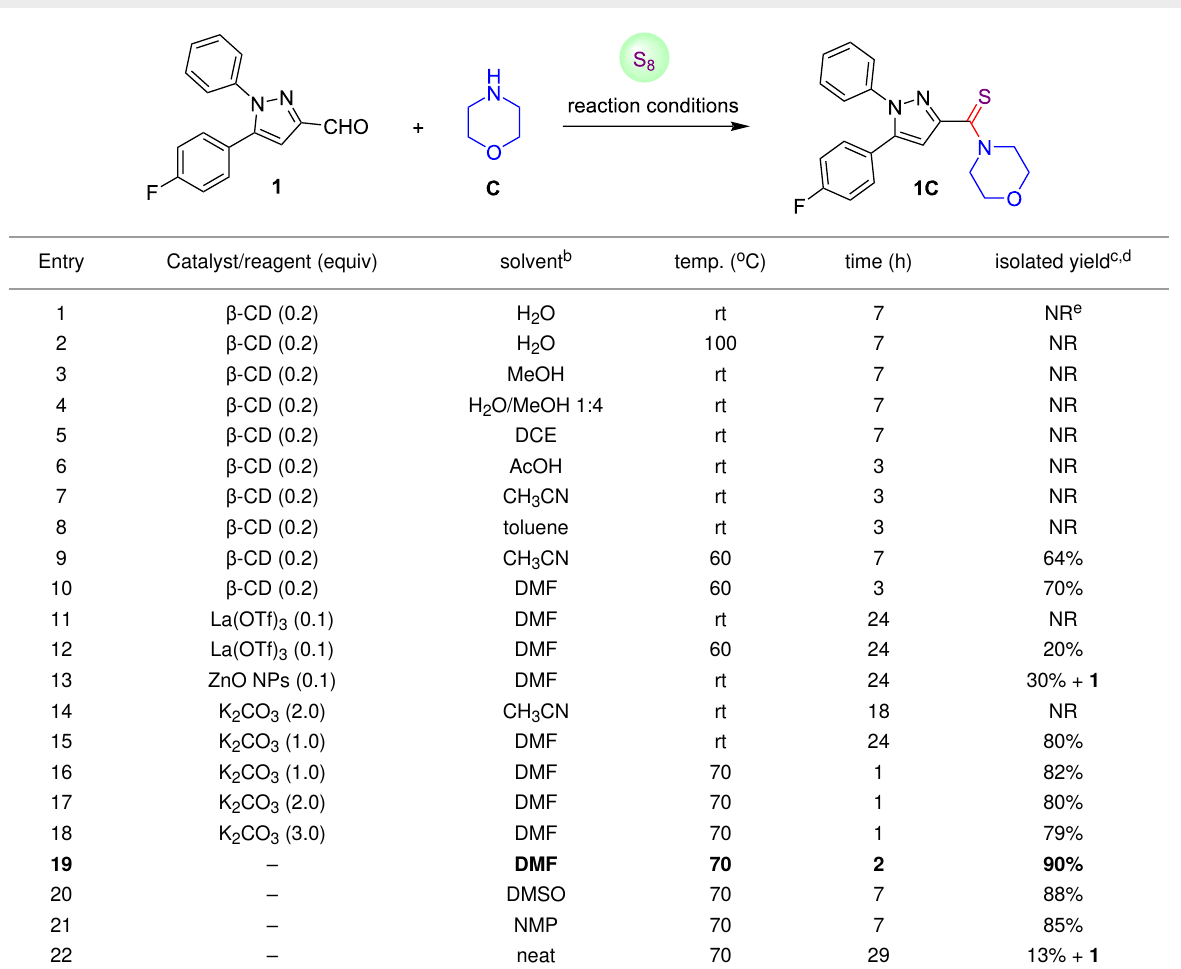
Table 1: Screening of reaction conditions towards the formation of pyrazole-conjugated thioamide.